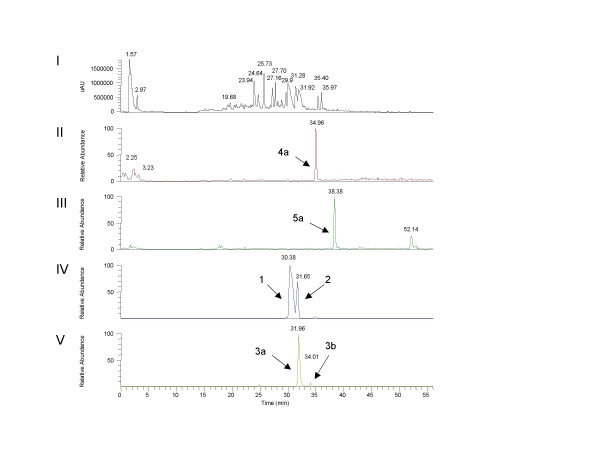
LC-UV-MS and LC-UV-MS/MS spectra of Chelidonium majus L. extract I: LC-UV (290 nm) chromatogram; II: LC-MS ion chromatogram of m/z 332.1 (extracted ion chromatogram); III: LC-MS ion chromatogram of m/z 348.4 (extracted ion chromatogram); IV: LC-MS/MS ion chromatogram of m/z 354.1; V: LC-MS/MS ion chromatogram of m/z 370.2.